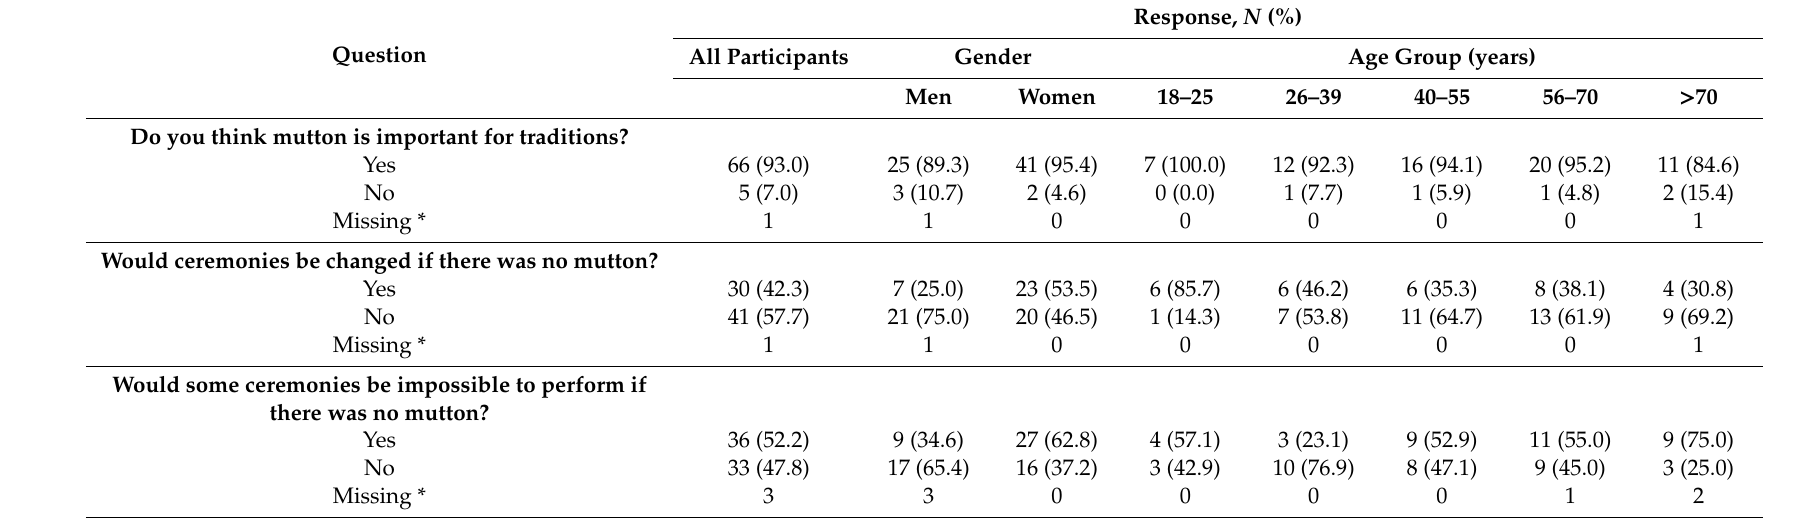
Table 2. Mutton ceremony perceptions among participants who completed the sheep survey, 2017 ( n =